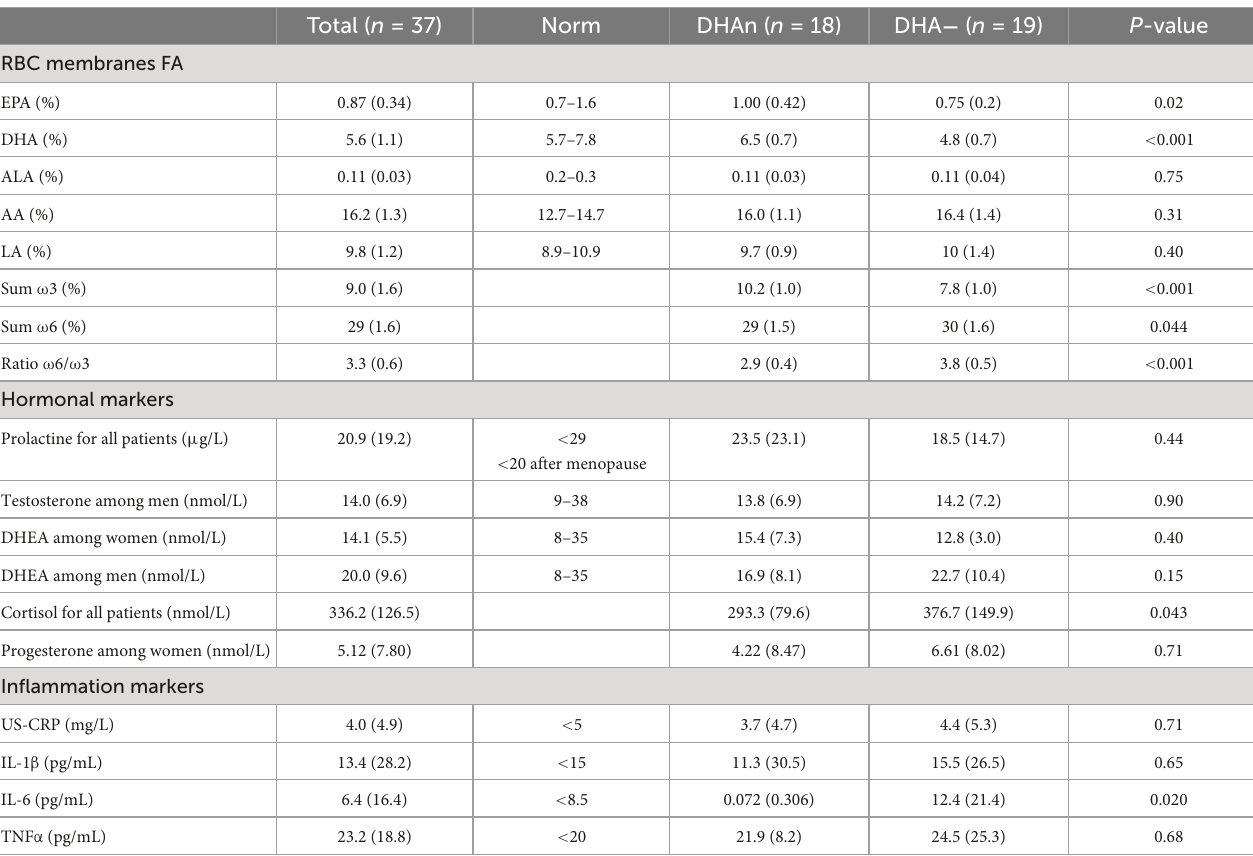
TABLE 2 Comparison of the RBC membranes fatty acid (FA) composition, hormonal markers and inflammation markers from patients of the two groups. Total ( n = 37) Norm DHAn ( n = 18) DHA − ( n = 19) P -value RBC membranes